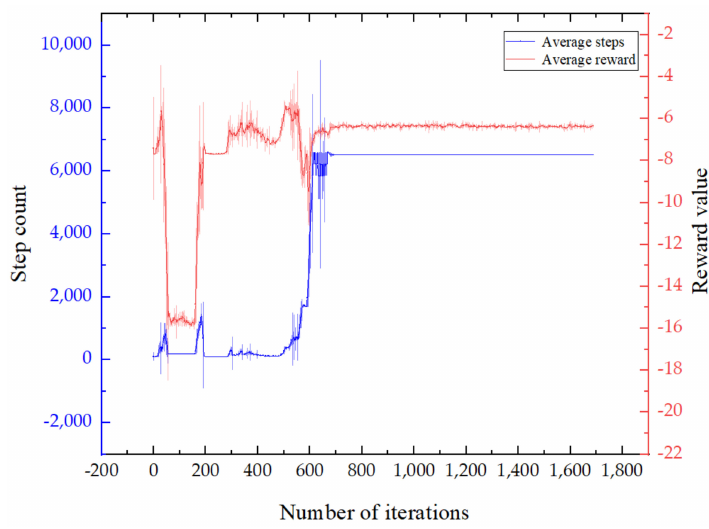
Figure 5. Training